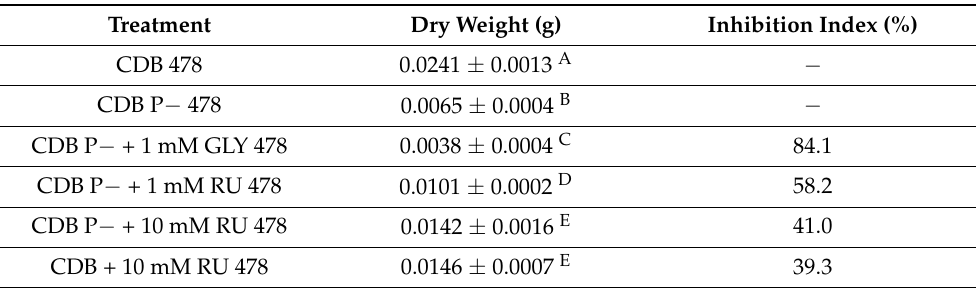
Table 6. Inhibition index and dry weights of fungal biomass after four weeks of growth at 25 ◦ C in liquid Czapeck dox medium (CDB) enrichment condition without phosphorus (CDB P − ) at a concentration of 1 mM both pure glyphosate (GLY) and RU. The data for dry weights (g) are expressed as the mean ± standard error of biological independent replicates.